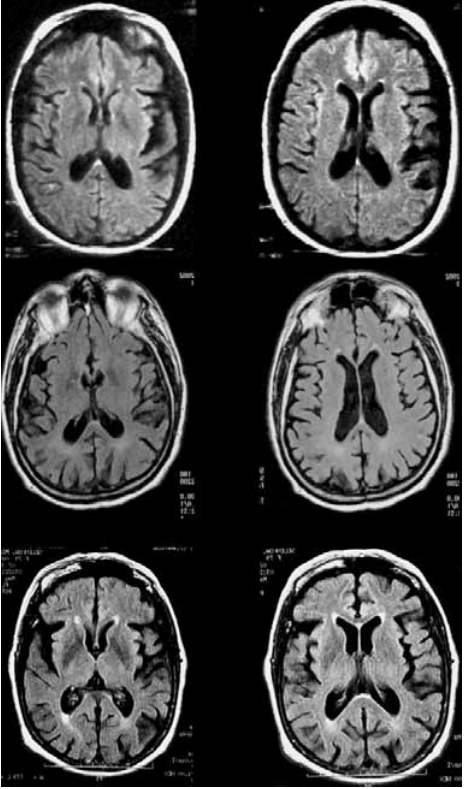
Fig. 2. MRI of AD patients. Axial MRI images of patients with AD, illustrating marked temporoparietal